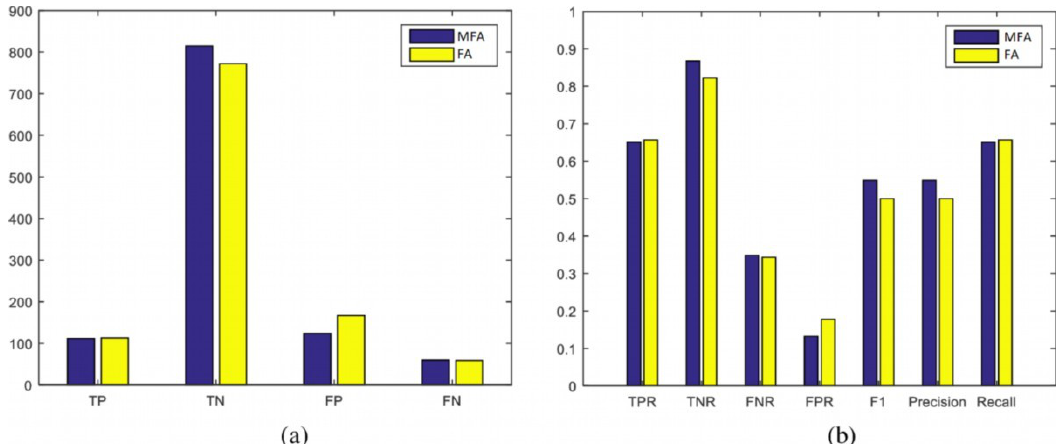
Figure 13. Scenario 2: Statistical evaluation of MFA-OSELM and FA-OSELM using two sets of measures, ( a , b ), for the UJIIndoorLoc dataset.